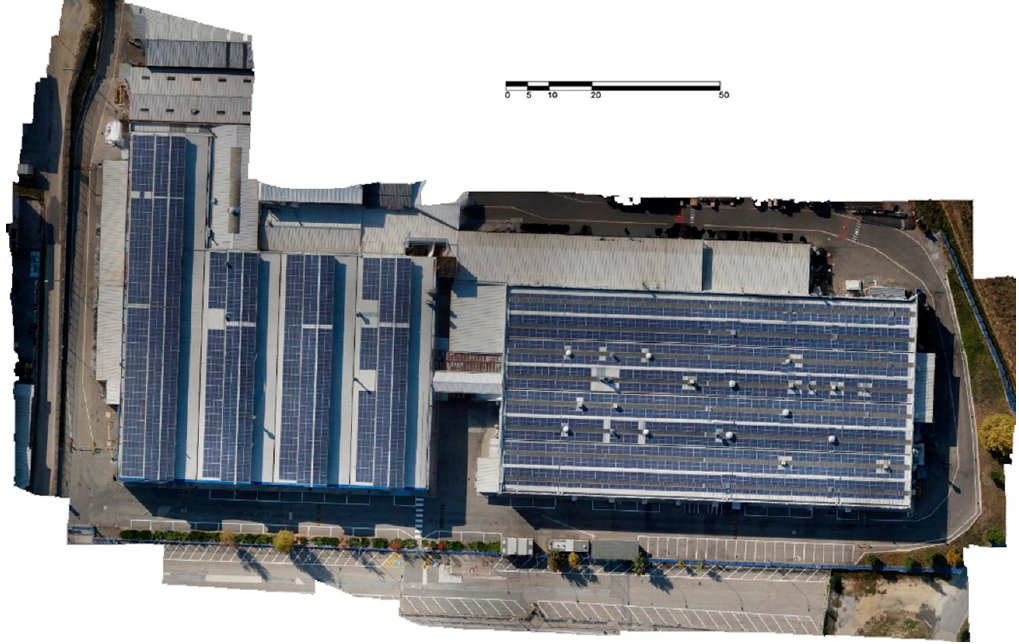
Figure 4. Orthophoto of the PV plant (Plant A).